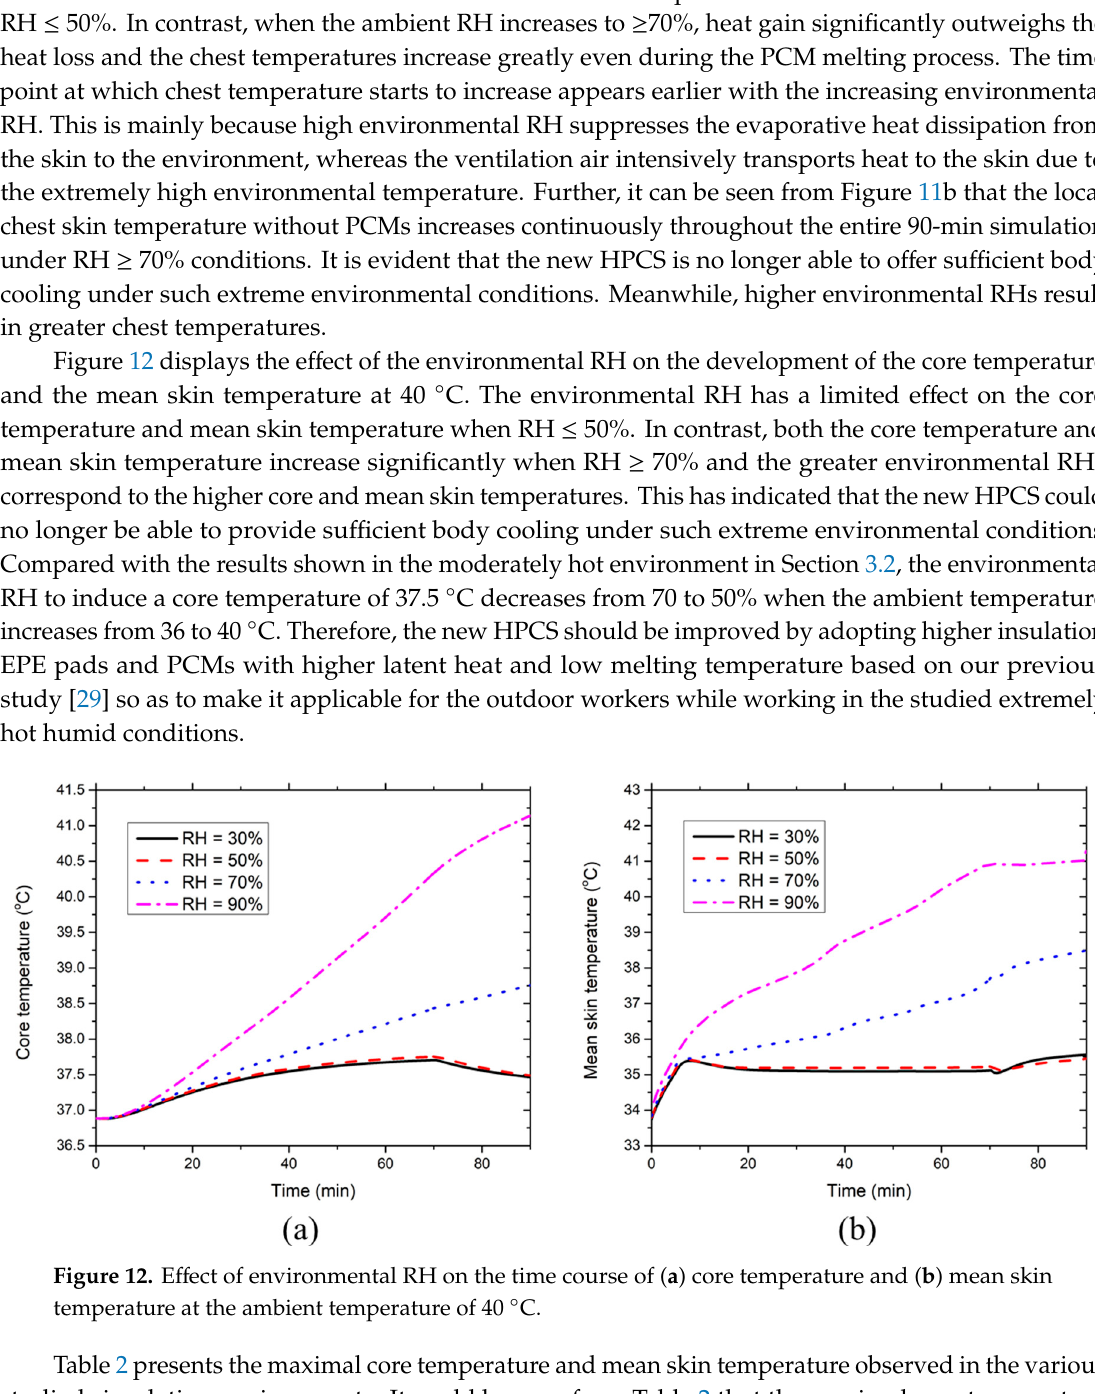
Table 2. Maximal core temperature and mean skin temperature observed in various studied simulation scenarios. Simulated Temperature (°C)